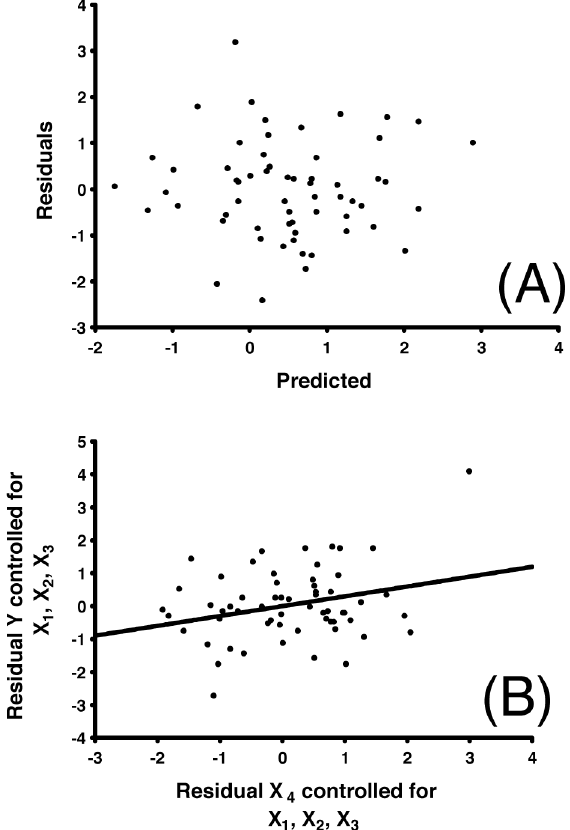
Fig. B1. Two graphic displays to detect influential data points in multiple regression using simulated data. (A) Plot of residuals vs fitted values from multiple regression. (B) the same data displayed in a partial regression plot shows a clear outlier. A very similar pattern would be shown in a partial residual plot (not shown). The independent variable X 0.038). Eliminating the influential data point (top right in the partial regression plot) causes the significance of X 0.386). Note that in the plot of residuals vs fitted values the influential data point could easily have remained